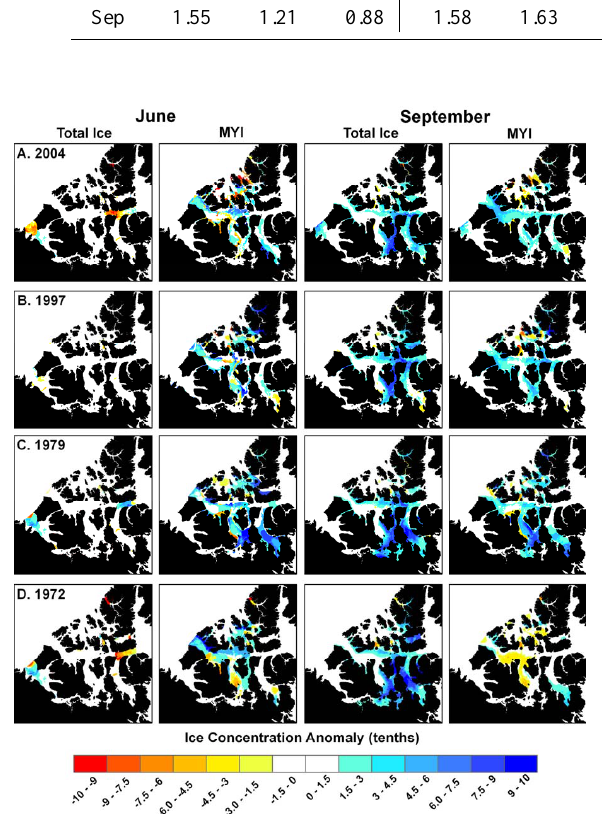
Figure 4. Spatial distribution of June and September total ice and multi-year ice (MYI) concentration anomalies (tenths) for heavy ice years of 2004, 1997, 1979 and 1972 within the Fig. 4. Spatial distribution of June and September total ice and Canadian Arctic Archipelago (A-D). Anomalies calculated with respect to the 1981-2010 multi-year ice (MYI) concentration anomalies (tenths) for the heavy climatology. ice years of 2004, 1997, 1979 and 1972 within the Canadian Arc- tic Archipelago (A–D) . Anomalies calculated with respect to the 1981–2010